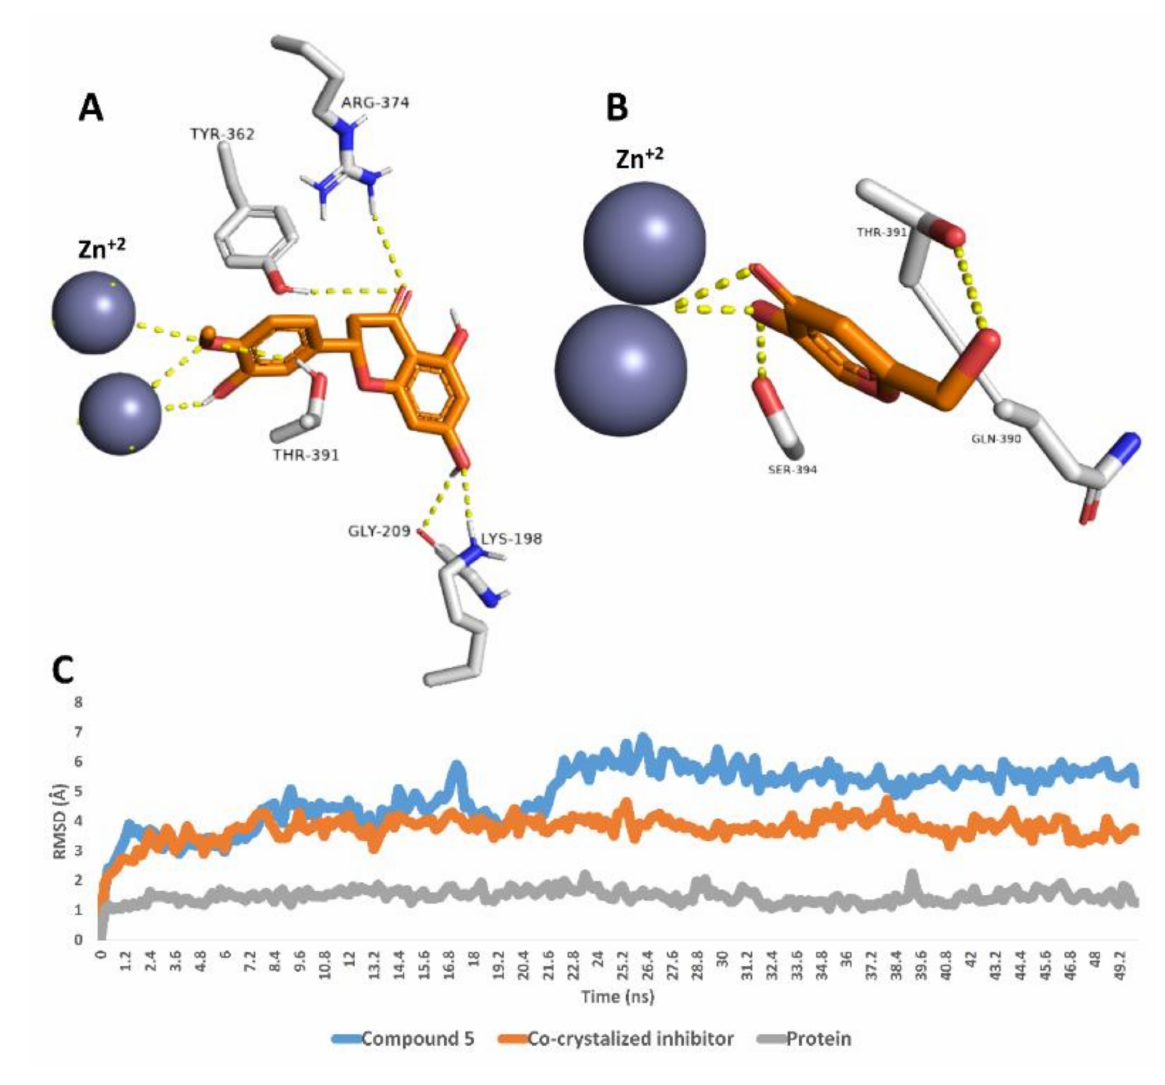
Figure 4. Binding modes of compound 5 and the co-crystalized inhibitor inside the active site of tyrosinase derived from the last snapshot of their 50 ns MDS ( A , B ). RMSDs of compounds 5 and the co-crystalized inhibitor inside the active site of tyrosinase over the 50 ns MDS ( C ). Table 3. In vitro inhibitory potential of compounds 2 , 3 and 5 against hyaluronidase, xanthine oxidase and tyrosinase enzymes (expressed as IC 50 in µ M ±